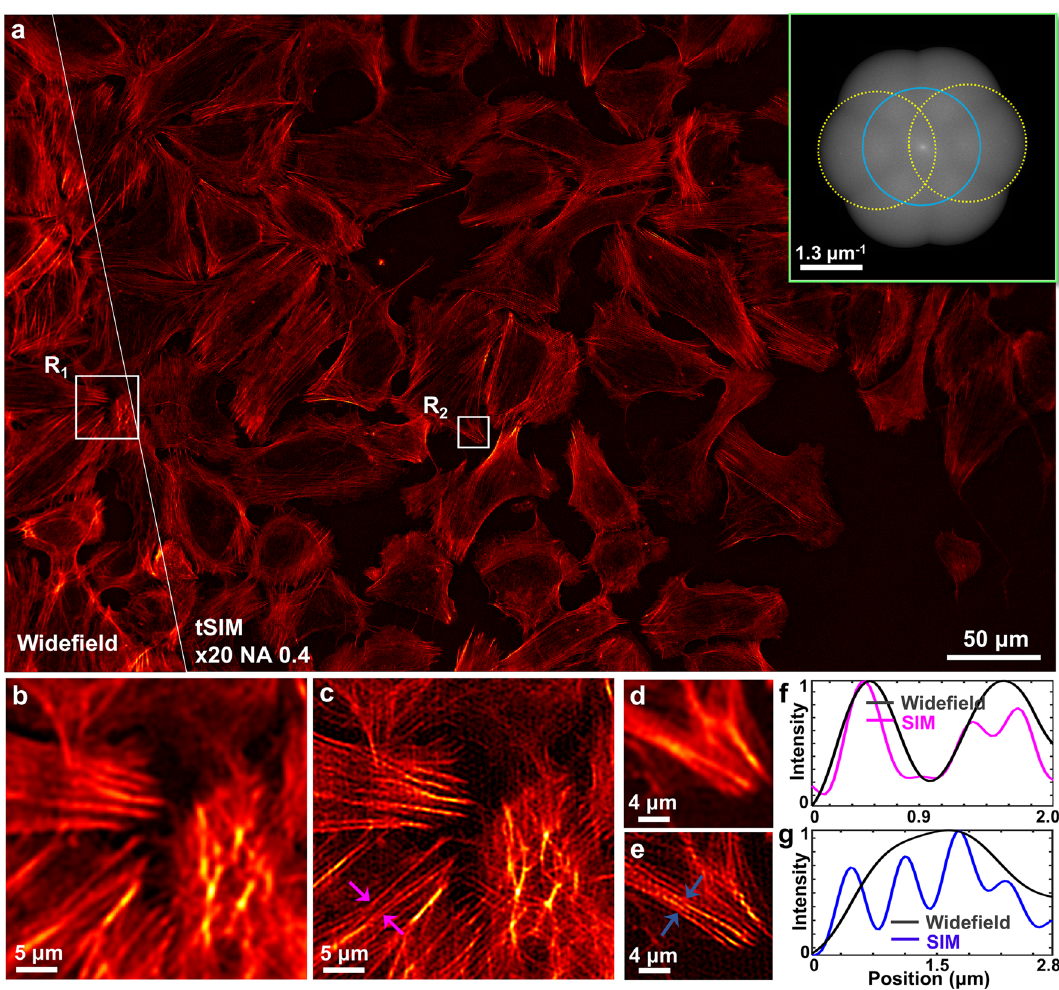
Figure 3. tSIM imaging of actin filaments in U2OS cells: ( a ) single FOV tSIM reconstruction versus diffraction limited image with the excitation/emission wavelengths of 532 nm/560 nm and inset shows spectra of the reconstructed image; ( b , d ) diffraction limited images of regions R 1 and R 2 ; ( c , e ) reconstructed tSIM image of regions R 1 and R 2 respectively; ( f , g ) intensity profile of a line marked between the arrowheads in ( c , e ity in the sample plane, which is below the diffraction limit of the detection system and thus fringes are not possible to observe. The raw moiré data is acquired by keeping the same detection objective lens (20X/0.4) as well as the previously mentioned imaging parameters. As before, 9 raw frames (3 phases × 3 orientations) were recorded in total. However, the conventional reconstruction approaches 39,40 suffer to process the raw data in this particular case as the illumination frequency exists outside the passband support. This is overcome by utilizing a TIRF-SIM like reconstruction approach 39 . The reconstructed and corresponding widefield image is shown in Fig. 4a. The inset of Fig. 4a represents the frequency spectra of the reconstructed tSIM image. The off-center spectral components (marked with dotted yellow) are not overlapping which demonstrates the coverage to the broader spectral range due to high frequency illumination patterns. Figure 4b, d represents widefield image of two zoom-in regions R 1 and R 2 respectively. Their corresponding super-resolved images are shown by Fig. 4c, e. The intensity line profiles between the magenta arrowheads in Fig. 4b, c and the blue arrowheads in Fig. 4b, c are plotted in Fig. 4f and Fig. 4 g respectively. This leads to a resolution of ∼ 290 nm with the FOV of size 0.56 mm × 0.35 mm. Resolution enhancement of tSIM under different illumination configurations in terms of spectral sup- port is presented in the supplementary text T6. A simulation study is presented by employing low magnification/ high NA objective lens and high tilt-angular illumination to demonstrate further resolution improvement with the same FOV. A 20X/0.65 objective lens is used for collection and the semi interference angle is kept θ = 70 ◦ which corresponds to an effective NA of 0.93. Random nanoparticle distribution of 80 nm diameter is chosen as the synthetic test target. The simulation result of single FOV tSIM reconstruction and diffraction limited image for 500 nm emission is shown in the Fig. 5a, inset shows frequency spectra of the reconstructed tSIM image. The Fig. 5b, f represent two zoom-in regions of the ground-truth object and Fig. 5c, g represent corresponding widefield images from the white-box regions R 1 and R 2 , respectively. The single FOV tSIM reconstructed images corresponding to these regions are shown in Fig. 5d, h. The intensity line profile of Fig. 5d (marked by yellow